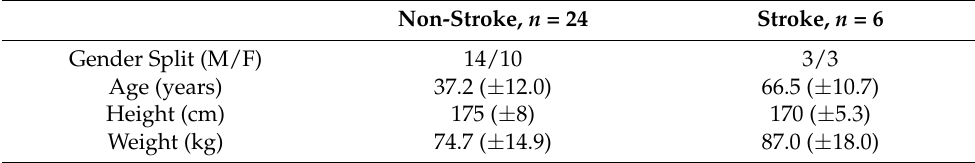
Table 1. Parameters with means and standard deviations of